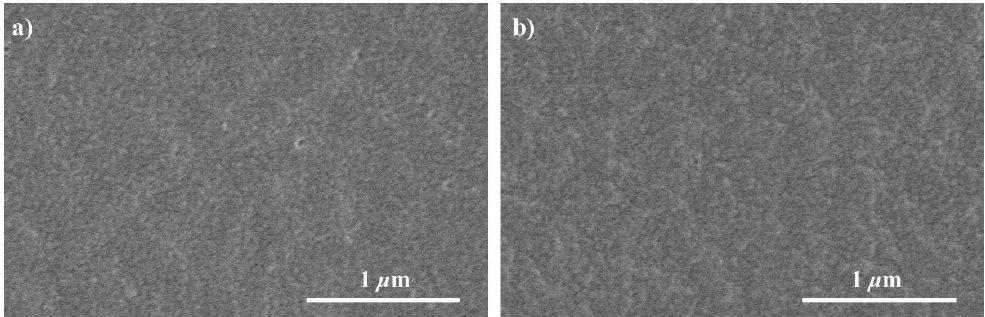
Figure 4. SEM images of the SF film ( a ) and SF/Gly/GA/Cur composite film ( b ).